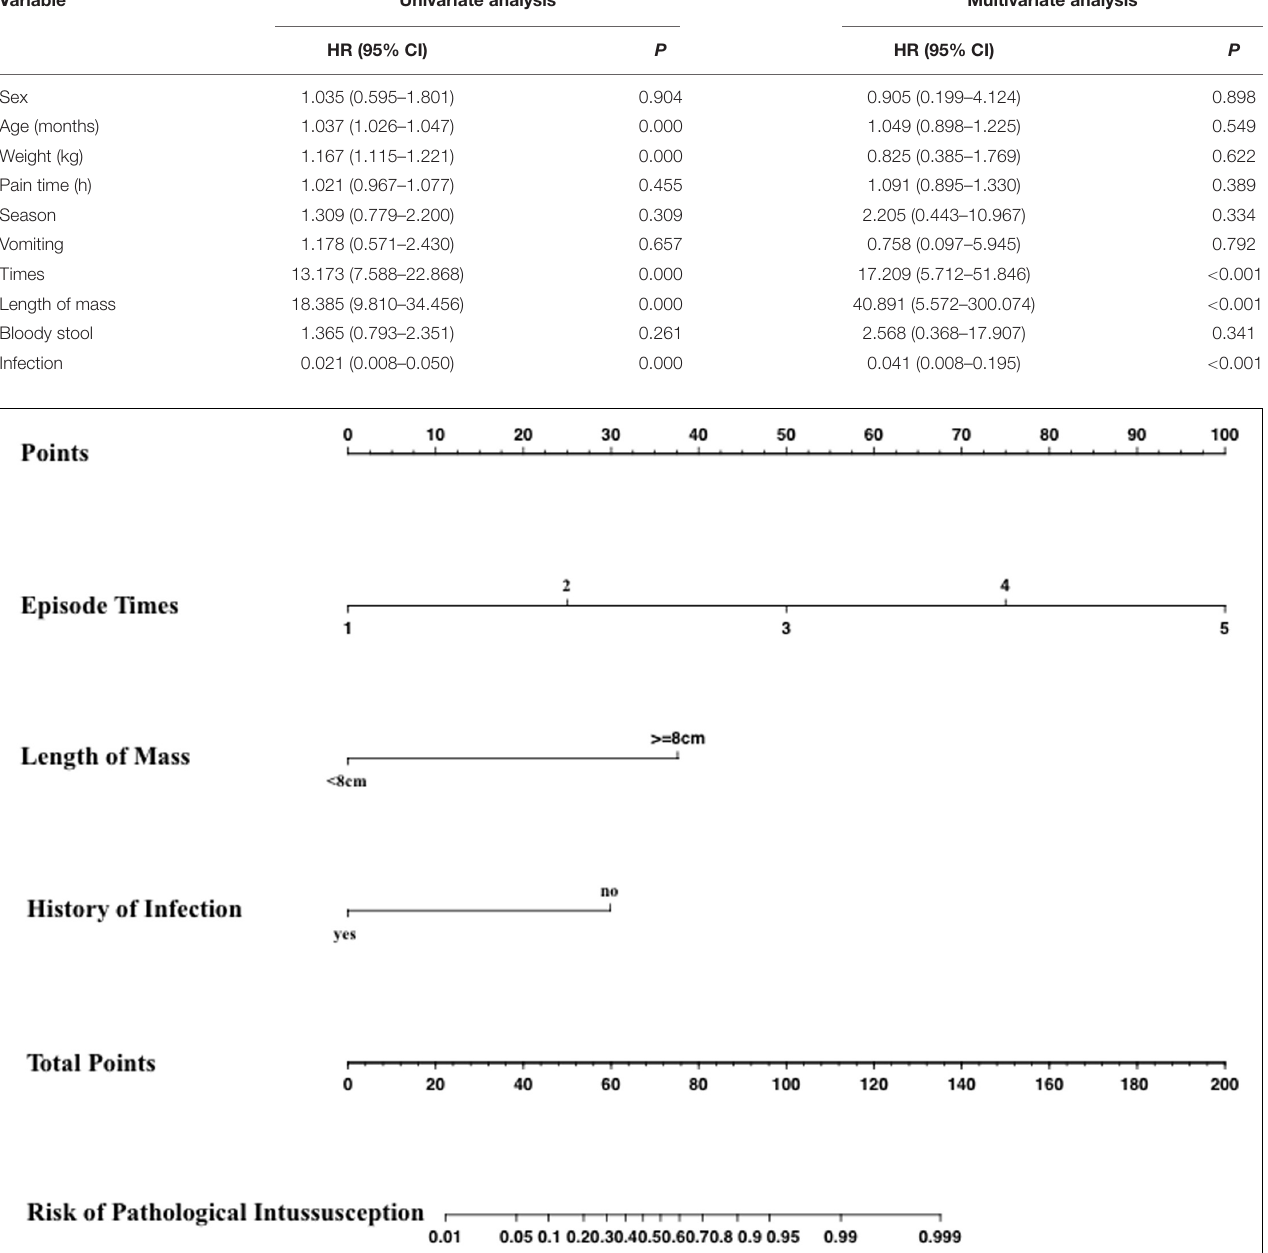
FIGURE 2 | Nomograms for predicting the risk of a pathological